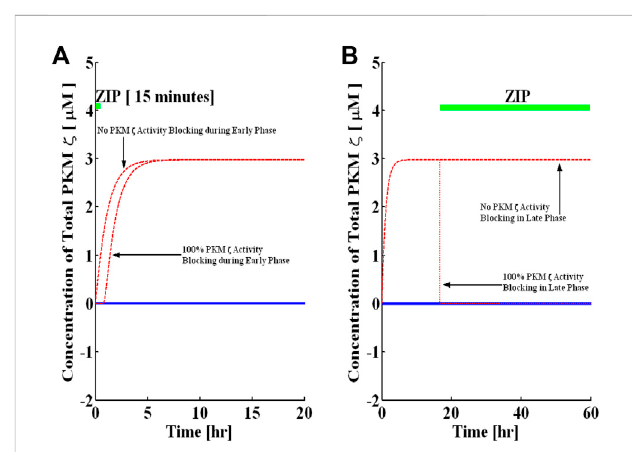
FIGURE 4 Blocking of PKM ζ activity in the early and late phases. Simulations are implemented with and without protein synthesis pulse U. A brief pulse of protein synthesis is used to mimic the induction of L-LTP by applying a high-frequency stimulus. The solid blue line represents PKM ζ , the concentration at basal levels of protein synthesis (without the application of pulse), and the dashed red line represents the PKM ζ concentration with the application of a protein synthesis pulse. (A) PKM ζ activity blocking during induction for 15-min (solid green line shows blockingtime).Completeblockingofactivityduringtheearlyphasedoes not affect the induction phase of L-LTP. (B) Activity blocking during maintenance for 90 h (solid green line shows blocking time). The complete activity blocking during maintenance rapidly reverses the established L-LTP from the up to the down